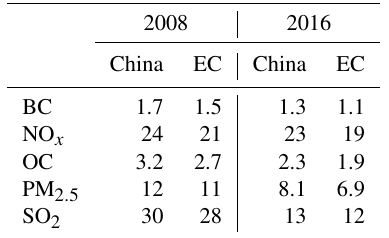
Table 2. Anthropogenic emissions for major species in China and eastern China (EC) between 2008 and 2016 (units: Tgyr − 1 ). The emissions were derived from the MEIC database (Zheng et al., 2018). The geographical range of the EC is shown in Fig. 1. BC: black carbon; NO x : nitrogen oxides; OC: organic carbon; PM 2 . 5 : particulate matter with aerodynamic diameter less than 2.5µm; SO 2 : sulfur